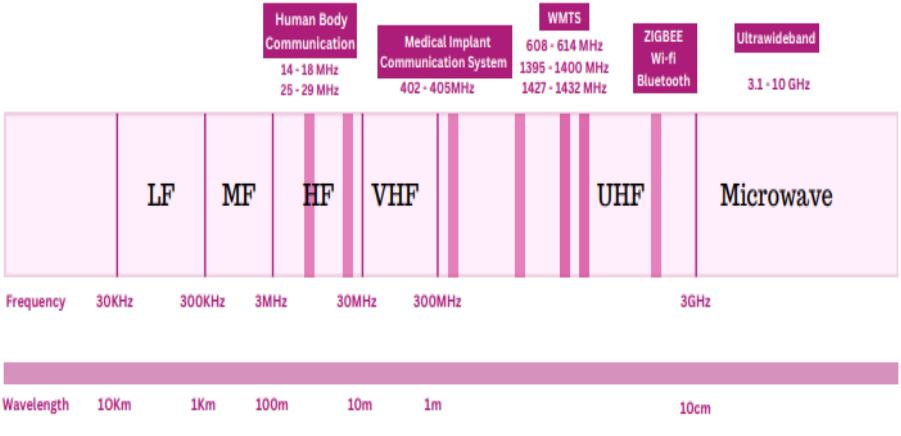
Figure 4. Wireless body area network bands.